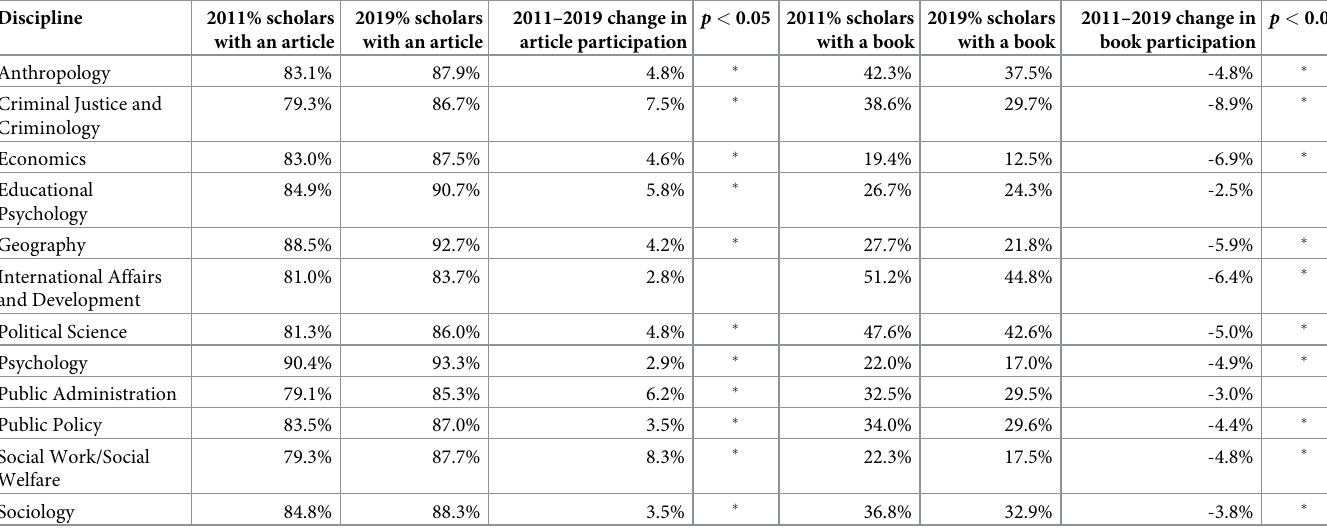
P-value is from Chi-squared test for difference in proportions who have published in the two